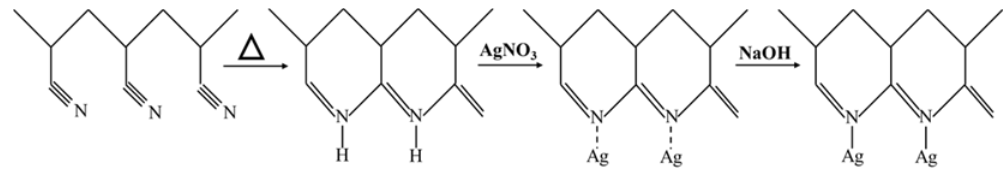
Figure 1. The mechanism of chemical reaction of AgNPs with PAN nanofibers.